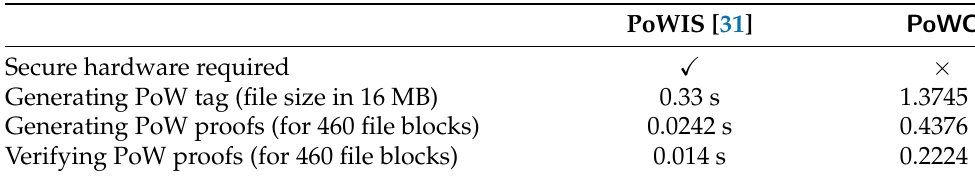
Table 2. Performance comparison between PoWIS and PoWC in this work. PoWIS has a much better performance by using dedicated secure hardware, but it relies on the assumption that the cloud server has secure hardware equipped. The PoWC is purely based on cryptography, and does not rely on the aforementioned assumption.